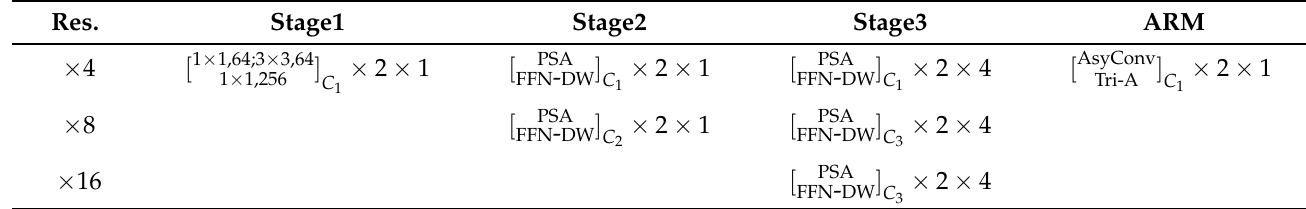
Table 1. The structure of HR-MPE. FFN-DW: feed-forward network with a 3 × 3 depth-wise con- volution, PSA: polarized self-attention, ARM: attention-refined module, AsyConv: asymmetric convolution, Tri-A: triplet attention, (1, 1, 4, 1): the number of modules, (2, 2, 2, 2): the number of